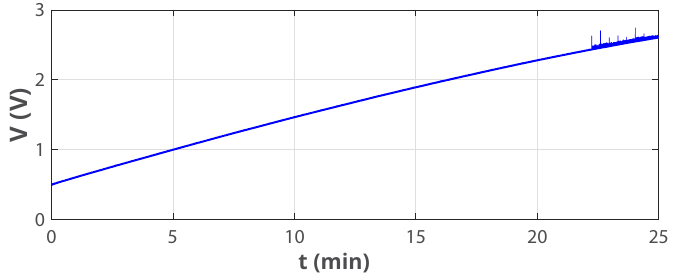
Figure 10. Bus voltage during